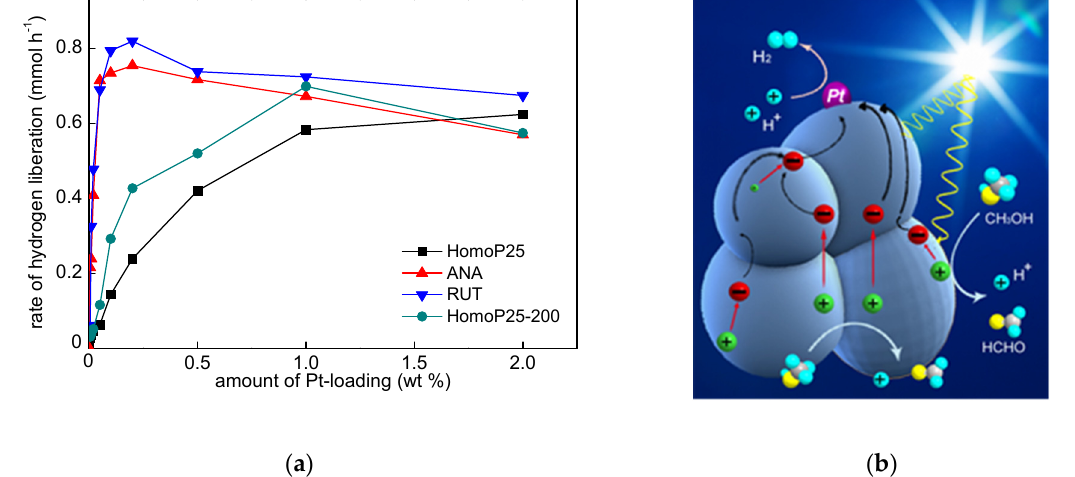
Figure 1. Hydrogen evolution on titania modified with platinum: ( a ) Dependence of photocatalytic activity on the amount of Pt loading on homogenized P25 (HomoP25), HomoP25 annealed at 200 ° C (HomoP25-200), and isolated phases from HomoP25 by the chemical dissolution method, followed by purification by thermal treatment: isolated anatase (ANA) and isolated rutile (RUT); ( b ) Schematic drawing showing IPCT on aggregated single-phase titania particles, e.g., Pt@ANA and Pt@RUT. Copyright 2018 Elsevier.